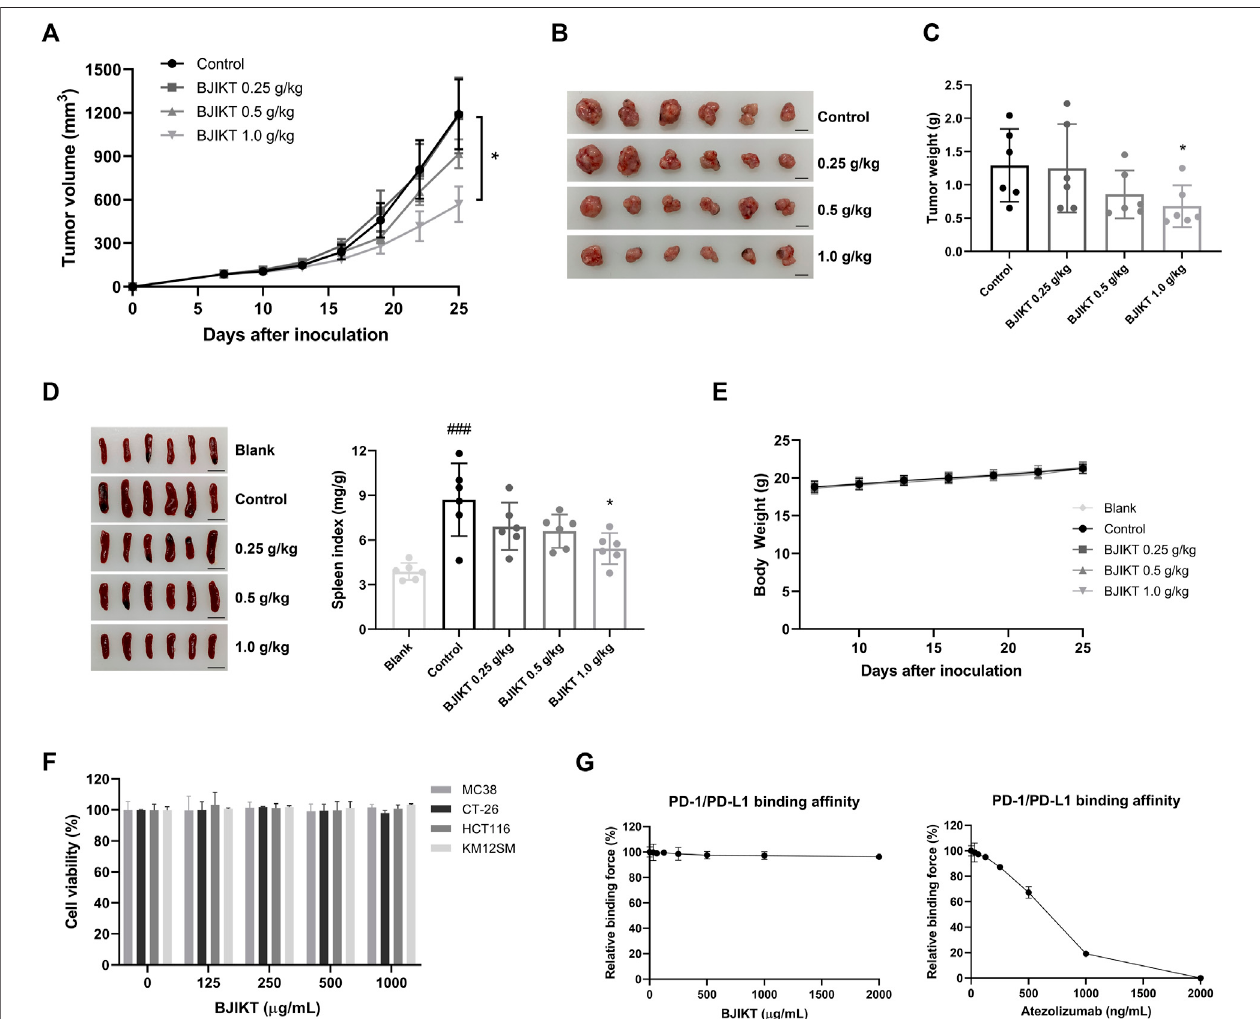
FIGURE 2 | BJIKT inhibited the tumor growth of the MC38 colorectal tumor. MC38 cells (5 × 10 5 cells) were inoculated subcutaneously into the right fl ank of C57BL/6 mice. Mice were divided into the control and BJIKT-treated groups ( n = 6, each group). One week after injection (a tumor volume nearly of 85 mm 3 ), BJIKT (0.25, 0.5, and 1.0 g/kg per day) were daily administered, and distilled water was used as a vehicle control. (A) Tumor volumes were measured every 3 days after the treatment. (B) Tumor images from mice. Scale bar represents 10 mm. (C) Tumor weights were shown. (D) Picture of the spleen and spleen index of mice were shown. Scale bar represents 10 mm. (E) Body weight changes of MC38-bearing mice. (F) Effect of BJIKT on the proliferation of colorectal cancer MC38, CT-26, HCT116, and KM12SM cells. CCK-8 was used to detect cell viability. (G) Effect of BJIKT on PD-1/PD-L1 binding af fi nity. The indicated concentrations of BJIKT were treated on plates coated with PD-L1 and then reacted with PD-1. Atezolizumab was used as a positive control. ### p < 0.001, compared to the blank group; * p < 0.05, compared to the control group.